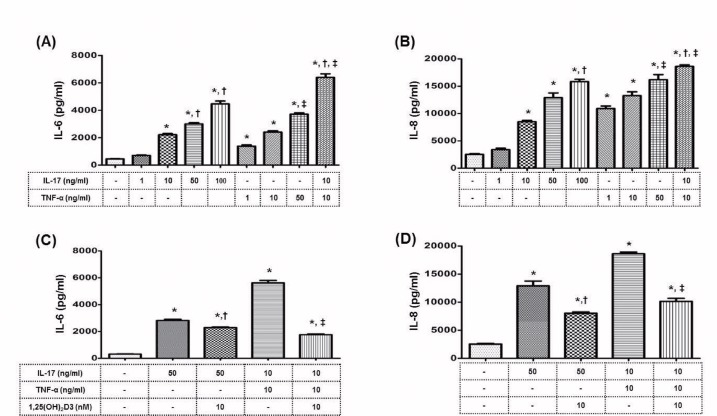
Effect of 1,25(OH)2D3 on the production of inflammatory cytokines by HRPTEpiC, induced by recombinant human IL-17 (rhIL-17) or human TNF-α.HRPTEpiC were cultured with rhIL-17 (0, 1, 10, 50, or 100 ng/mL) or TNF-α (0, 1, 10, or 50 ng/mL) for 48 hours, and the production of (A) IL-6 and (B) IL-8 was measured (n = 3). Note that IL-6 and IL-8 levels were significantly increased by IL-17 or TNF-α in a dose-dependent manner. *P<0.05 vs. Nil and †P<0.05 vs. IL-17 1 ng/mL and ‡P<0.05 vs. TNF-α 1 ng/mL. (C) IL-6 and (D) IL-8 production by HRPTEpiC which were pretreated with 1,25(OH)2D3 (10 nM) as indicated, and then cultured for 48 hours with IL-17 (0, 10, or 50 ng/mL) or TNF-α (10 ng/mL). Note that the addition of 1,25(OH)2D3 significantly decreased the IL-6 or IL-8 level, which was increased by IL-17 or TNF-α. *P<0.05 vs. Nil and †P<0.05 vs. IL-17 50ng/mL and ‡P<0.05 vs. IL-17 10ng/mL + TNF-α 10 ng/mL.